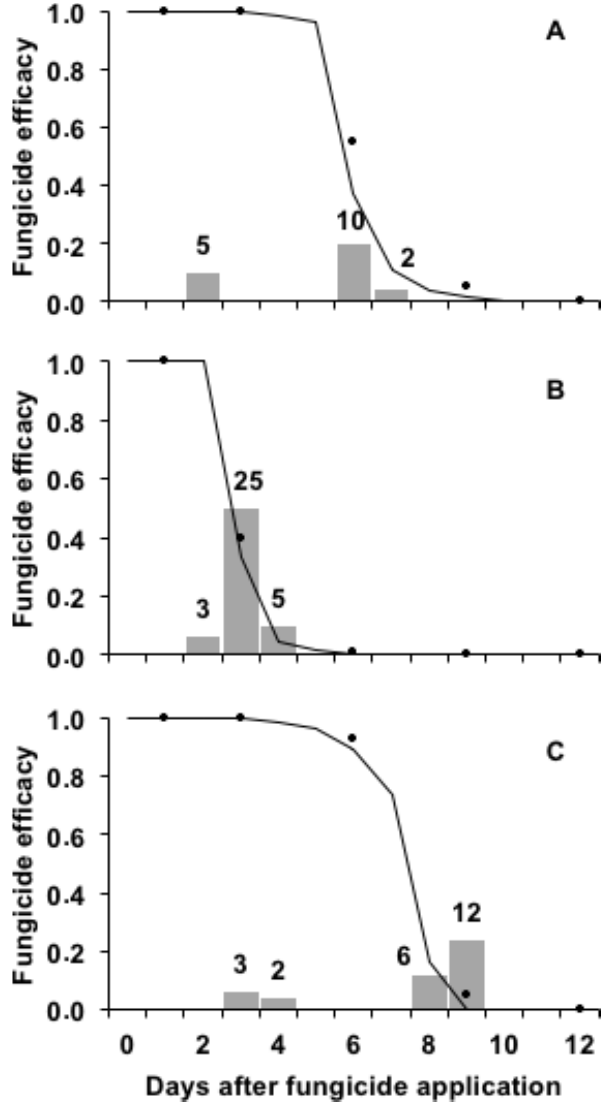
Figure 6. Loss of fungicide efficacy over time in a commer- cial vineyard in 2016, as predicted by equation EF t = EF 0 / (1 + α × exp (β × (t + (∑Rain × P / R) + (B t - B 0 ) / B))) [6], with the following parameter estimates: EF 0 = 1; α = 0.00005; β = -0.984; P = 7 d; R = 40 mm rain; and B = three